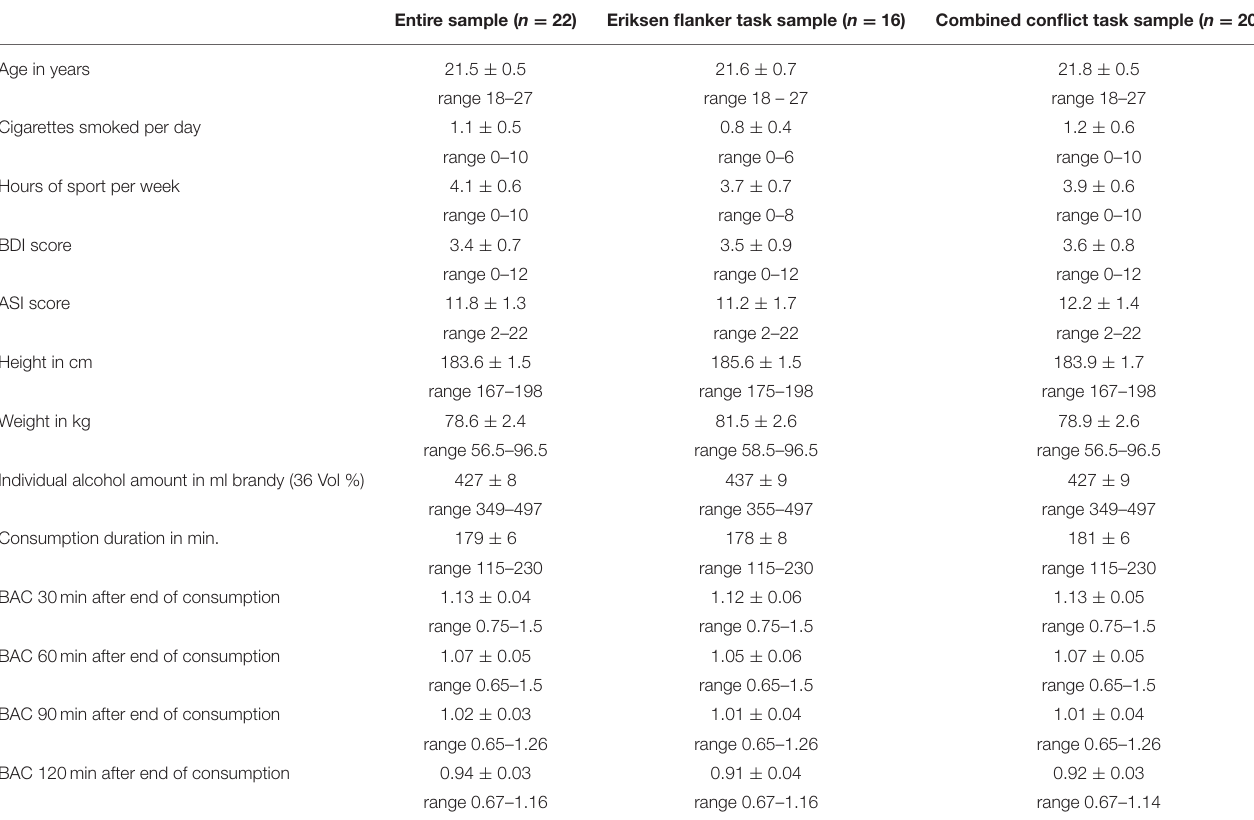
TABLE 1 | Sociodemographic and intoxication-related